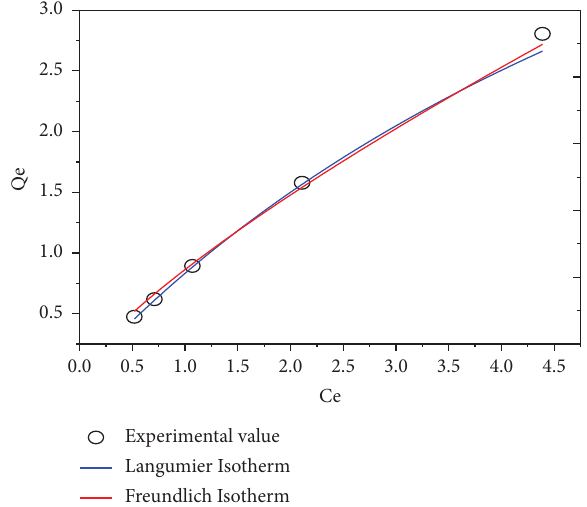
Figure 13: Nonlinear regression of adsorption isotherm